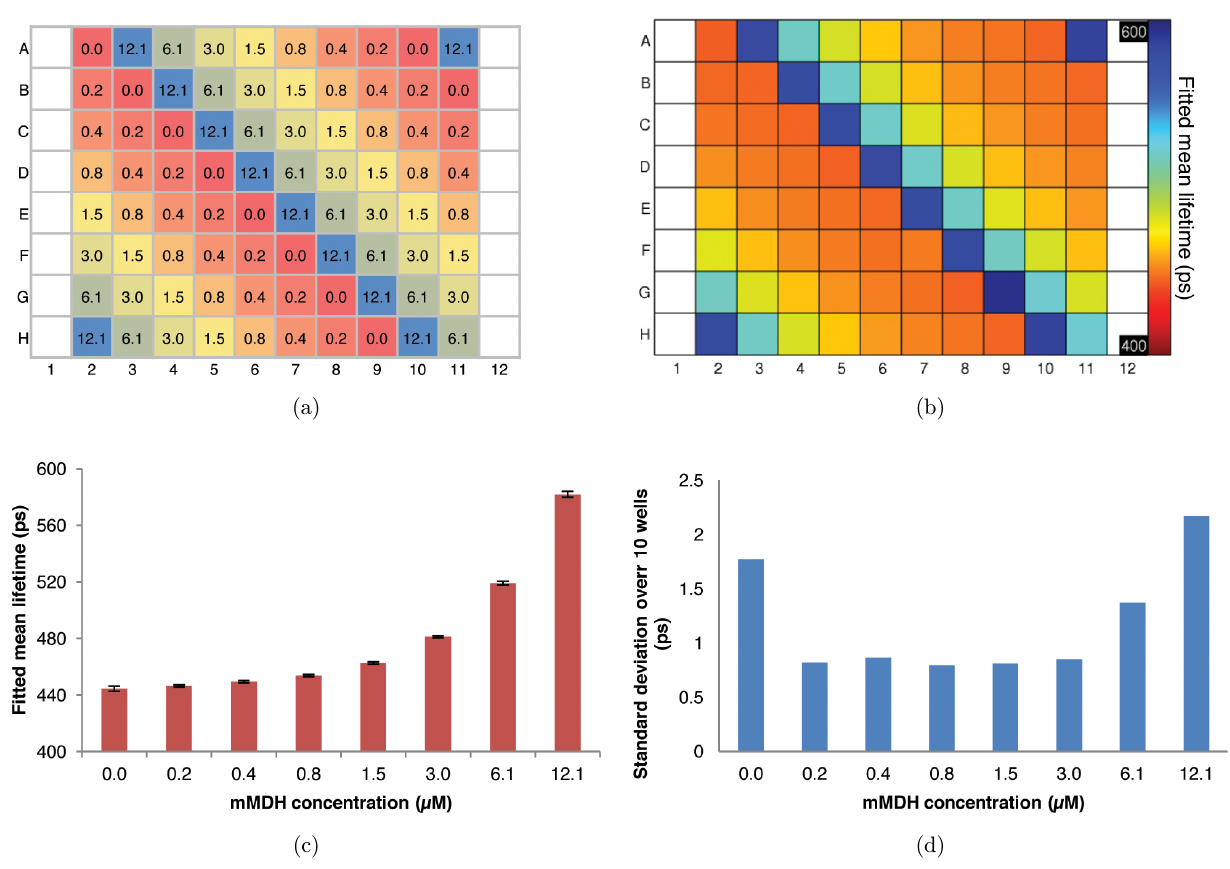
Fig. 3. Results showing repeatability of lifetime results across a 96-well plate. (a) Map showing plating layout for NADH – mMDH measurements of lifetime repeatability; numbers associated with wells represent mMDH concentrations in (cid:1) M. (b) Plate map of mean ¯tted lifetime across each well. (c) Plots showing ¯tted mean lifetime averaged over repeat wells. (d) Standard deviations across repeat wells to illustrate how repeatable are the lifetime measurements between repeat